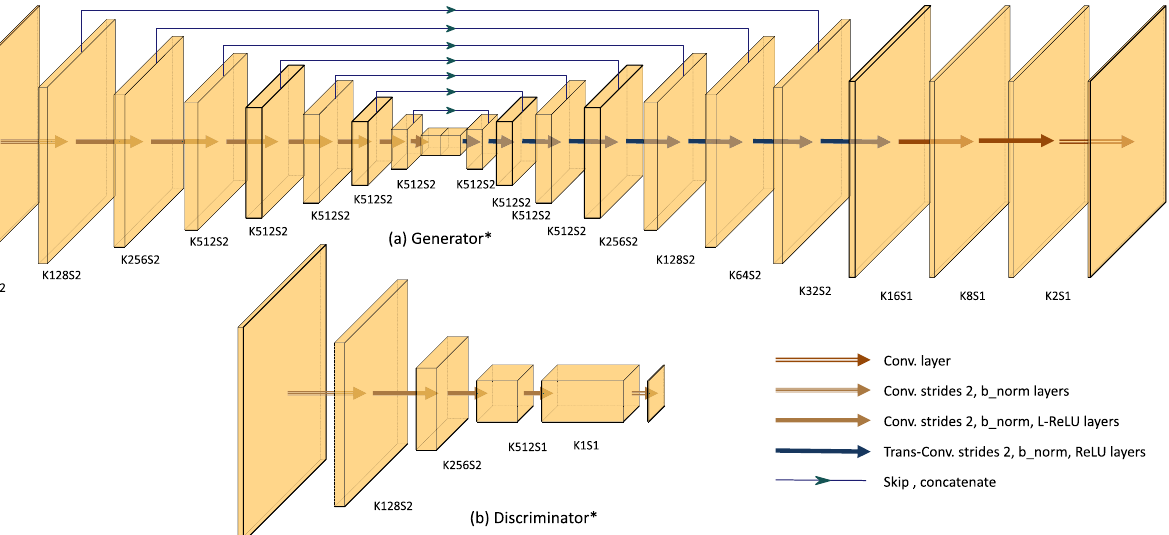
Figure 10. End-To-End Generative Adversarial Network architecture. K is the number of kernels, and s is the stride. The generator is shown in ( a ). The input is a 256 × 256, two-channel image composed of horizontal and vertical tagging images. The output is the corresponding two Eulerian principal strains with shapes of 256 × 256 × 2. The discriminator is shown in ( b ). The input to the discriminator constitutes the tagging images concatenated with either the generated or the ground-truth principal strain maps. *This figure is not to